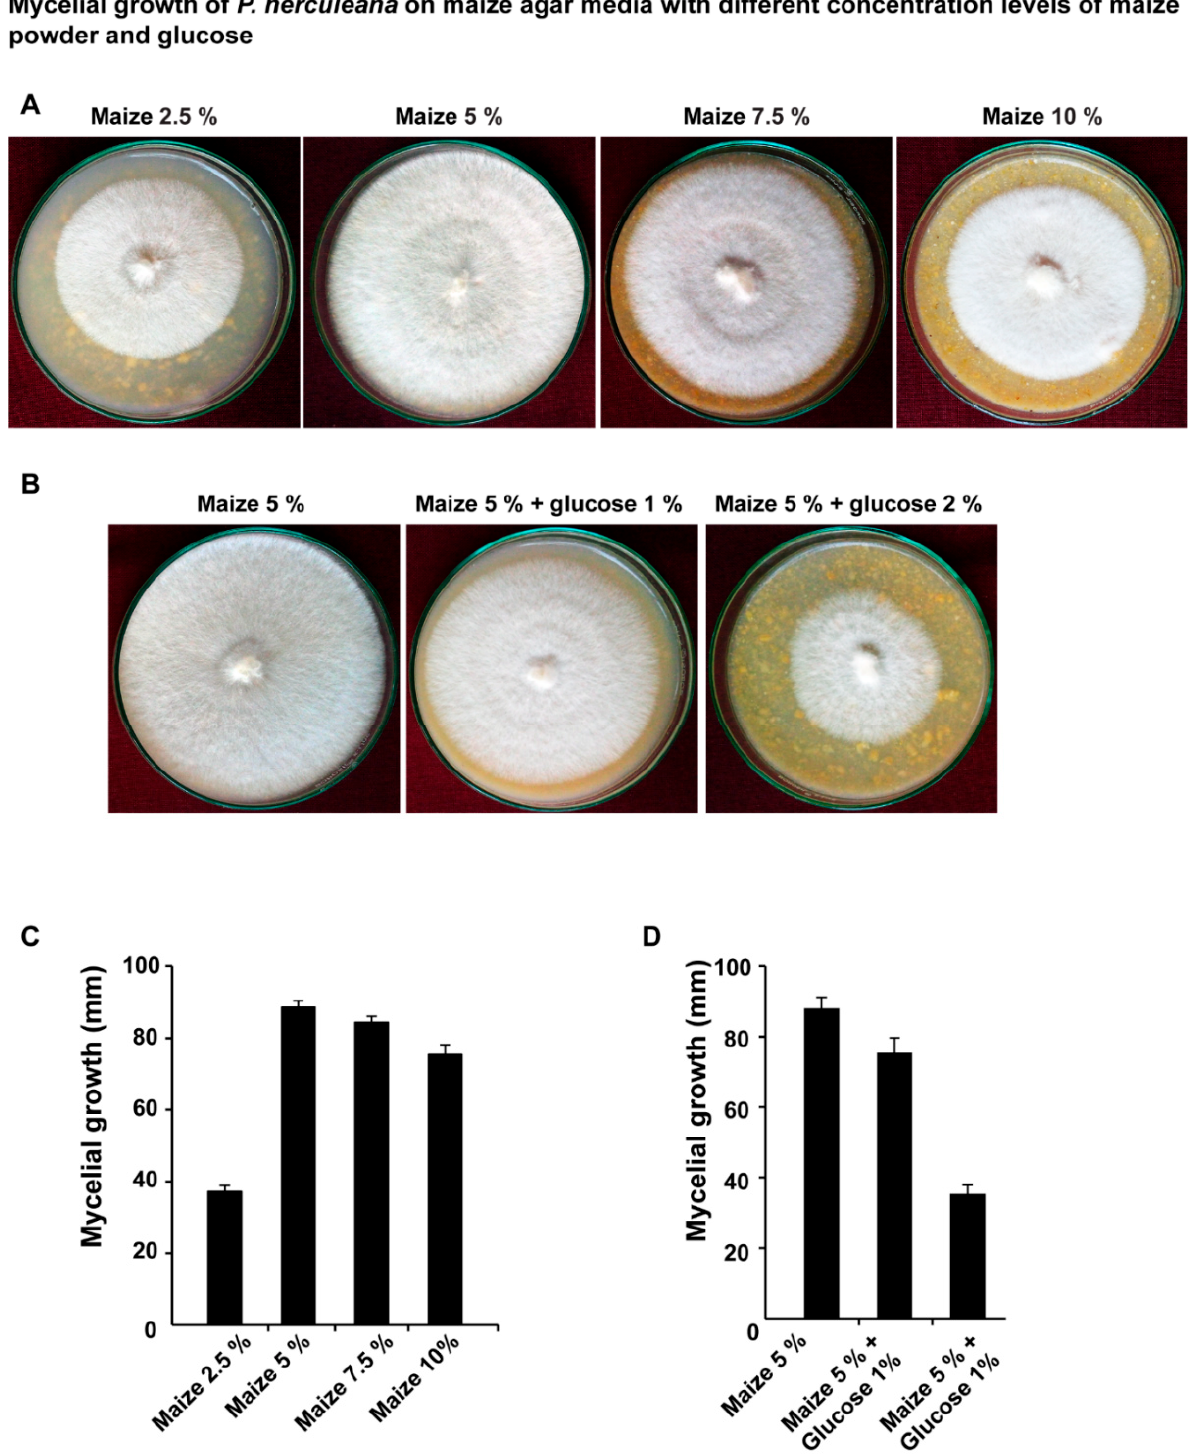
Figure 3. Mycelial growth of Phellorinia herculeana on maize agar media with different concentration levels of maize powder and glucose. ( A ): Mycelial growth of P. herculeana on maize agar medium at different concentration levels of maize powder; ( B ): Mycelial growth of P. herculeana on 5% maize agar medium incorporated with glucose; ( C ): The radial growth of P. herculeana , grown on maize agar medium with different concentration levels of maize powder, was measured in millimeter. Error bar indicates the standard deviations; ( D ): The radial growth of P. herculeana , grown on 5% maize agar medium incorporated with glucose, was measured in millimeter. Error bar indicates the standard deviations.